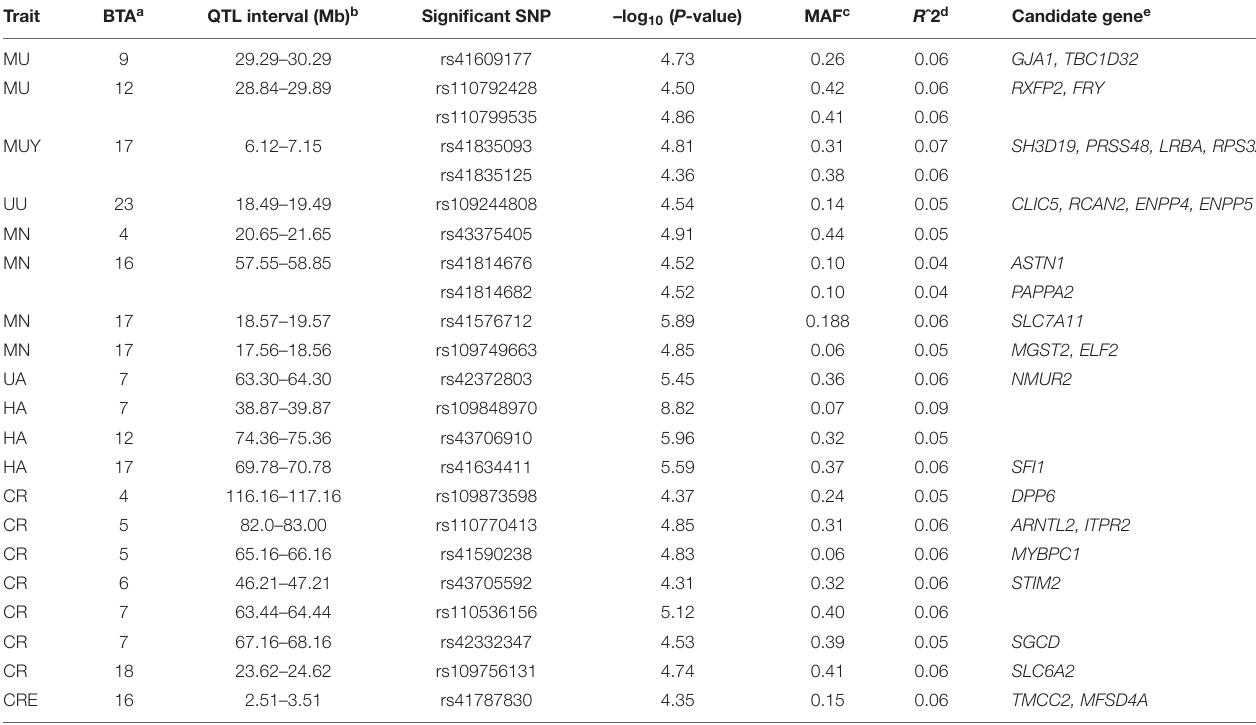
TABLE 2 | Overview of QTLs and suggested candidate genes for N-traits identified by GWAS.